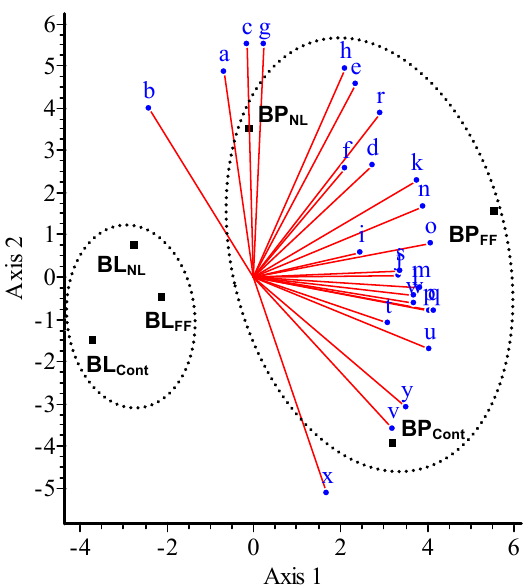
Figure 6. PCA applied to catabolic response profiles of black locust (BL) and black pine (BP) mineral soil amended with NL (subscript) and FF (subscript) litter extracts of black locust. Control (non-amended soil) are indicated as Cont (subscript). Legend for substrates in Figure 2.